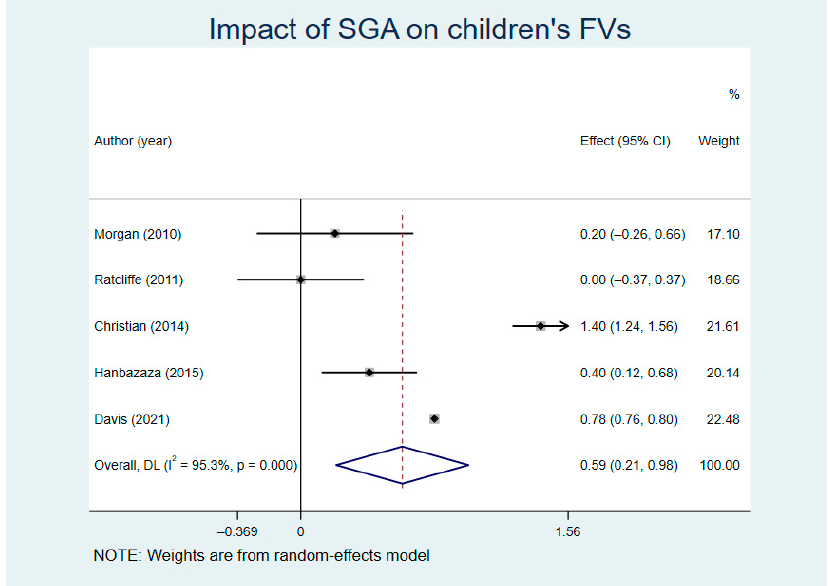
Figure 4. Impact of SGA on children’s fruit and vegetable intakes (FVs).